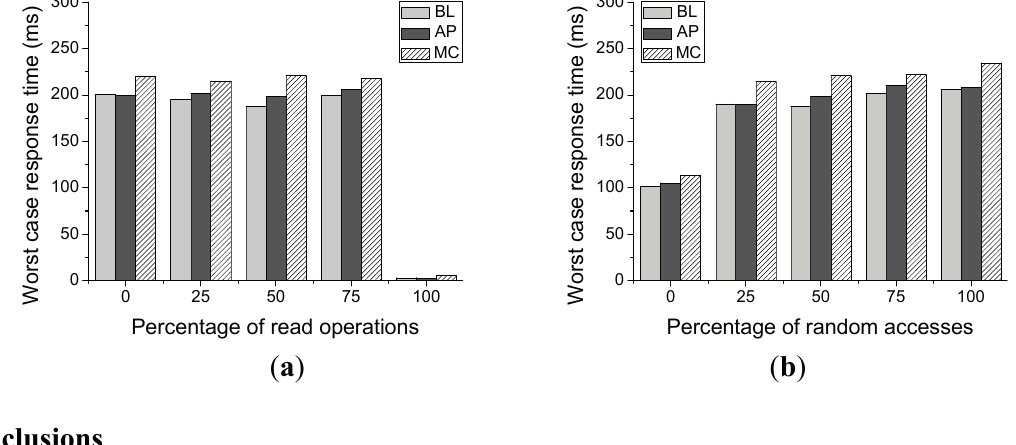
Figure 16. The worst-case response time for Baseline (BL), Meta-Cure (MC), and Asymmetric Programming (AP) with different ( a ) Percentages of read operations ( b ) Ratios of random